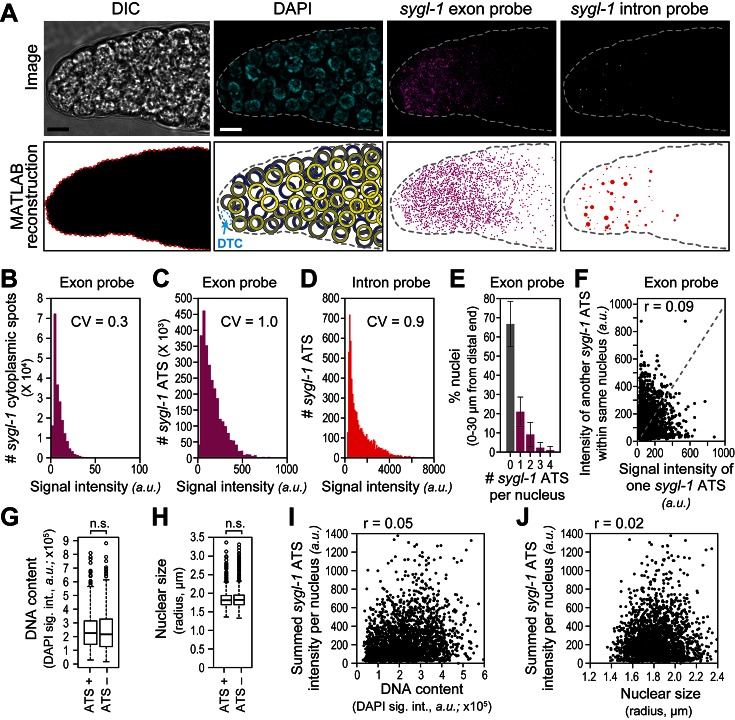
The sygl-1 transcriptional response to Notch signaling.(A) MATLAB reconstruction of distal gonad. Top row, DIC image is one Z-plane; all others are Z-projections. Far left, DIC was used to determine gonadal outline; middle-left, DAPI reveals nuclei (blue); middle-right, signal from sygl-1 exon probes shows sygl-1 cytoplasmic mRNAs and nuclear active transcription sites (ATS) (magenta); far right, signal from sygl-1 intron probes show only ATS (yellow). Bottom row, outputs from custom MATLAB code (Source code 1). Far left, gonadal outline (red dashed line), middle-left, germ cell nuclei false-colored in a depth gradient (yellow-blue) according to Z-position and with DTC (cyan) excluded; middle-right, cytoplasmic mRNAs (magenta) with nuclear ATS excluded computationally; far right, ATS (red) with smFISH signals scaled according to intensity. Scale bar: 5 μm. (B) Signal intensities of cytoplasmic dots from sygl-1 exon probes. A total of 222,260 spots were analyzed from 78 gonads. Raw values from Z-planes were normalized to background levels in the same plane and the mean intensity value set to 10 arbitrary units (a.u.) for each gonad. CV: coefficient of variation (CV <1, significantly narrow distribution). (C,D) Signal intensities of sygl-1 ATS. A total of 2627 spots were analyzed from 78 gonads. (C) Intensities of sygl-1 ATS using exon probes. We first normalized raw values to background levels in the same Z-plane and then normalized to mean intensity of sygl-1 cytoplasmic spots seen with the same probe in the same gonad. Mean intensity of sygl-1 ATS was 172.0 a.u., or roughly 17-fold more than the mean intensity of sygl-1 individual mRNAs. (D) Intensities of sygl-1 ATS using intron probes. Raw values were normalized to background levels in the same Z-plane. (E) Number of sygl-1 ATS per nucleus in 7018 nuclei (78 gonads). Error bars: standard deviation. (F) Pair-wise comparisons of sygl-1 ATS intensities within one nucleus (78 gonads), using normalized values from exon probe. Each black dot represents one pairing. Grey dashed line indicates a perfect correlation (Pearson’s correlation coefficient r = 1); r indicates the correlation coefficient from data in the graph. (G-J) sygl-1 transcriptional activity is independent of cell cycle stage. The cell cycle stage was monitored for DNA content (summed DAPI signal) or nuclear size, which are correlated (Figure 2—figure supplement 1A), in all nuclei located 0–30 µm (1–7 gcd) from the distal end (n = 6979 nuclei total); n.s.: not significant (p>0.05) by t-test. The cell cycle is also independent from nuclear location in the gonad (Figure 2—figure supplement 1B,C). (G,H) DNA content (G) or nuclear size (H) was compared between ATS-positive and ATS-negative cells. For all box-and-whisker plots in this study, the bold line in the box shows the median; top and bottom of box are the third and first quartiles, respectively; whiskers, maximum and minimum of data points; circles, outliers (value greater than 1.5X first or third quartile from the median). (I, J) Summed sygl-1 ATS intensity was estimated by pooling all ATS signal intensities (a.u.) within the same nucleus. Each black dot represents a single nucleus.